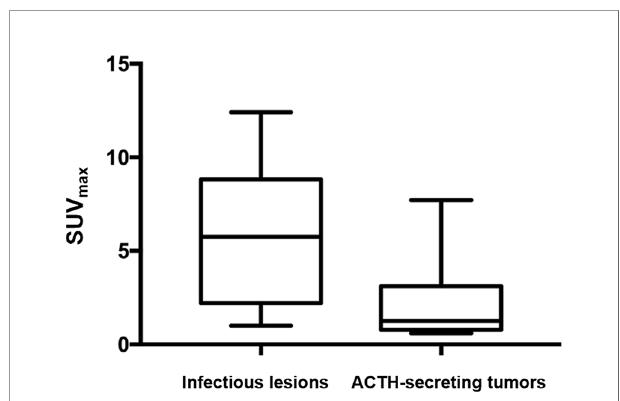
FIGURE 1 | SUV max was signi fi cantly higher for infectious lesions than for ACTH-secreting tumors ( P =